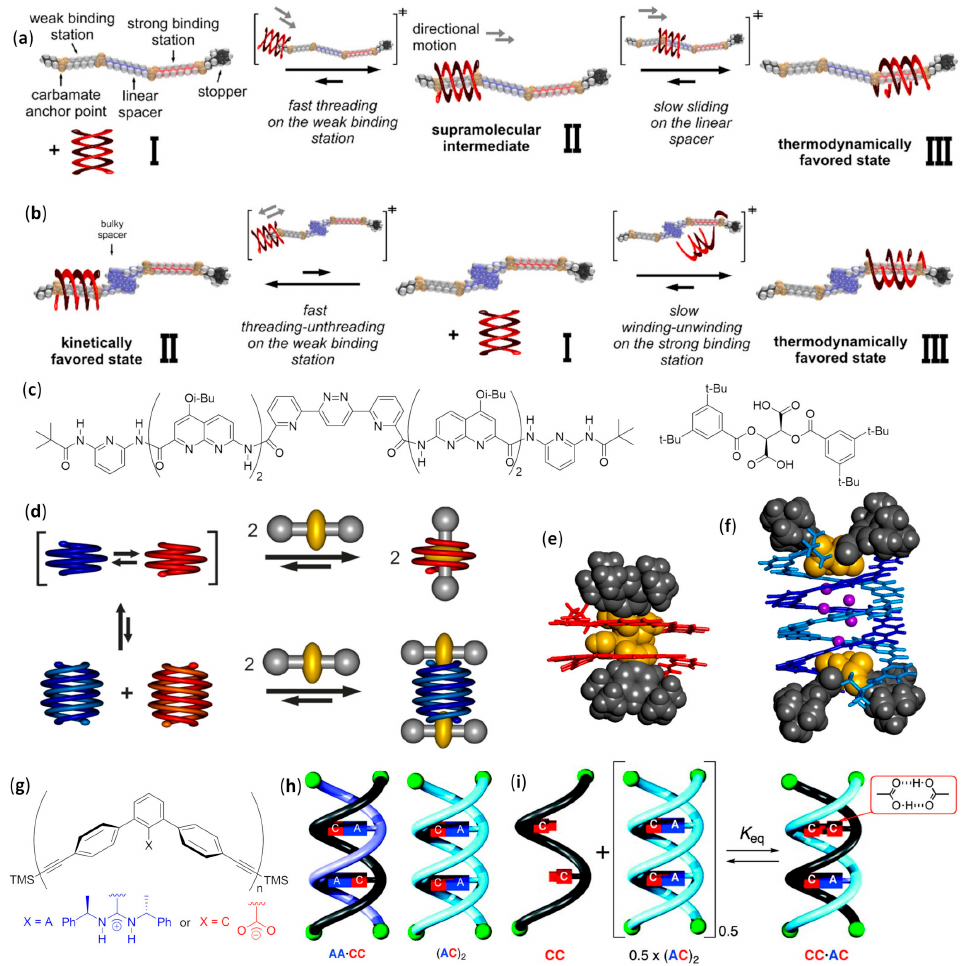
Figure 12. Different pathways followed by the double helix (host) when the double station rod (guest) has ( a ) a non-bulky spacer (sliding pathway) and ( b ) a bulky spacer (unwinding/rewinding pathway, bottom), respectively (strands are stylized and color-coded, while the guest is in space-filling model; adapted with permission from Ref. [159]); ( c ) Structure of heptameric foldamer and tartrate derivatives implied in equilibria reported in panel d (Ref. [161]); ( d ) Overall equilibrium between M (red) single-helix foldaxane with ( L )-tartrate and P (blue) double helix complexed with two ( L )-tartrate molecules (reprinted with permission from Ref. [161]); Computed structures of ( e ) 1:1 ( M )-helix ⸧ ( L )-tartrate foldaxane and ( f ) 2:2 host – guest complex [( P )-double helix] 2 ⸧ [( L )-tartrate] 2 (adapted with permission from Ref. [161]); ( g ) General structure of m -terphenyl foldamers (Refs. [162 – 164]); ( h ) Examples of self-complementary (AC) 2 and complementary duplexes (AA·CC) (A = m -terphenyl diamidine, C = m -terphenyl acid; reprinted with permission from Ref. [163]); ( i ) Equilibrium between (AC) 2 and CC·AC (A = m -terphenyl diamidine, C = m -terphenyl acid; adapted with permission from Ref. [163]).